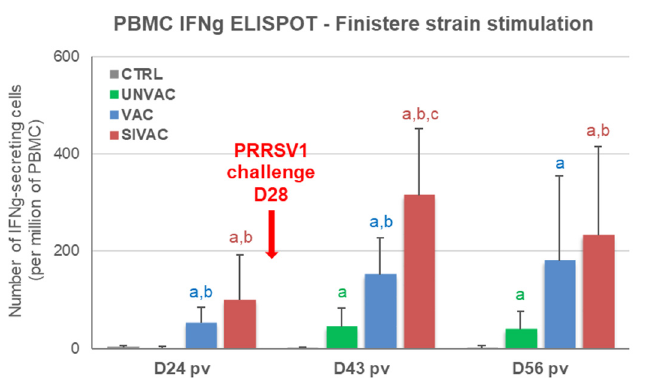
Figure 11. Anti-PRRSV cell-mediated response to the Finistere strain assessed by IFNg ELISPOT in peripheral blood mononuclear cells (PBMC). Data are reported as the mean (± SD) of the results obtained from all piglets in each group. Different letters (a,b,c) indicate that the considered group (specified by its color) was significantly different from the CTRL group (a), from the UNVAC group (b) or from the VAC group (c) with p < 0.05.